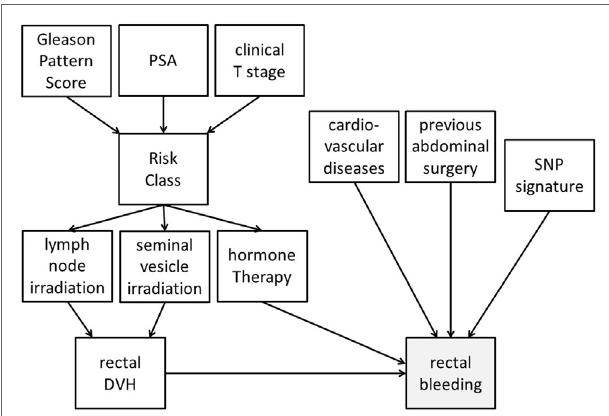
FiGURe 4 | Possible representation of a Bayesian network directed acyclic graph for predicting late rectal bleeding after radiotherapy for prostate cancer. The network includes tumor-related characteristics (PSA, Gleason pattern score, and clinical T stage) which determine risk class and consequently radiotherapy targets (irradiation of pelvic lymph nodes and of seminal vesicles) and use of concomitant hormone therapy. Treatment variables influence the dosimetry of organs at risk [rectal dose–volume histogram (DVH)], and this has a causal effect on late rectal bleeding probability. Clinical (presence of a previous abdominal surgery and of cardiovascular diseases) and genetic [single-nucleotide polymorphism (SNP) signature] variables with (causal) associations with rectal bleeding are also included in the